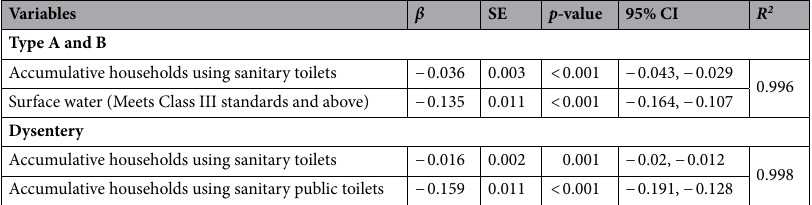
Table 4. Multiple linear regression models for intestinal infectious diseases in Jiangsu Province.